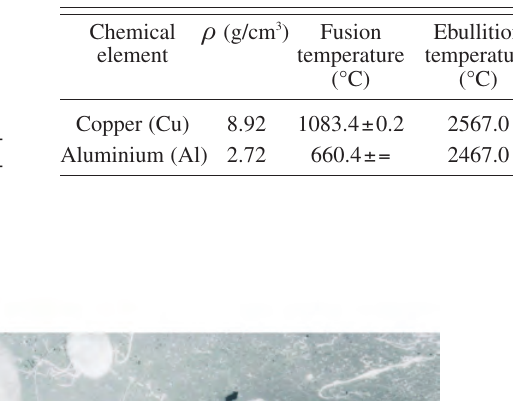
Table IV. Density, fusion and ebullition tempera- tures for copper and aluminium, two of the elements the LWP cable is made of (Weast,